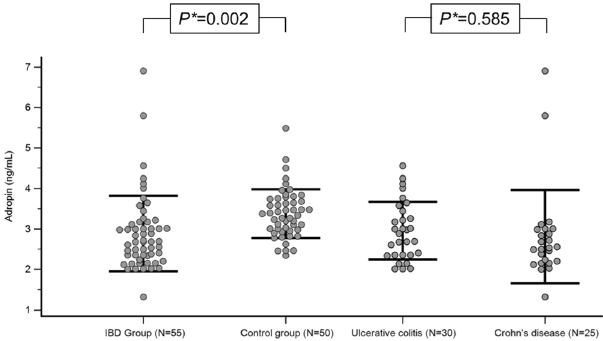
Figure 1. Serum adropin levels in IBD group and control group ( A ) and in ulcerative colitis group and Crohn’s disease group ( B ). * t-test for independent samples.